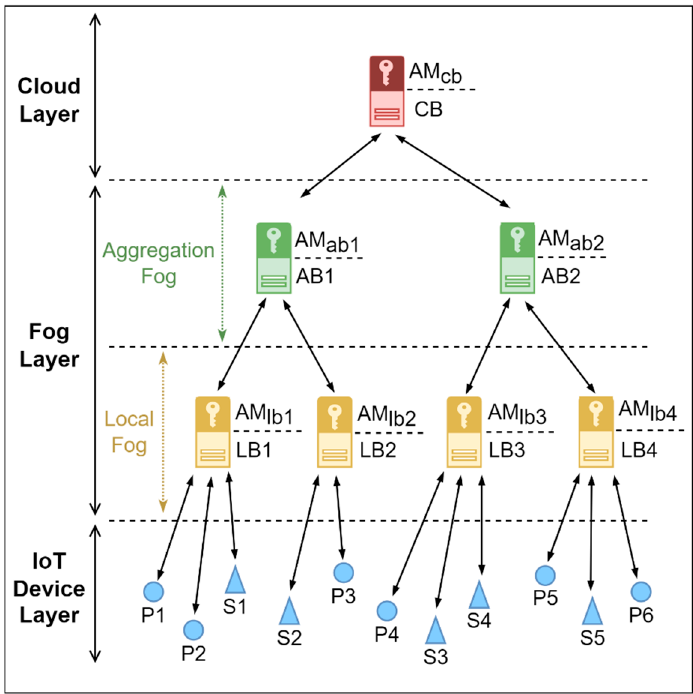
Figure 6. Authentication architecture for Mu-TiMB.